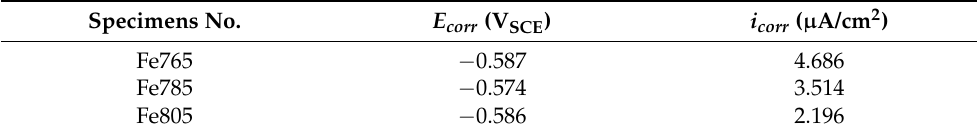
Table 2. Parameters obtained from the simulation circuit in H ank’s solution.